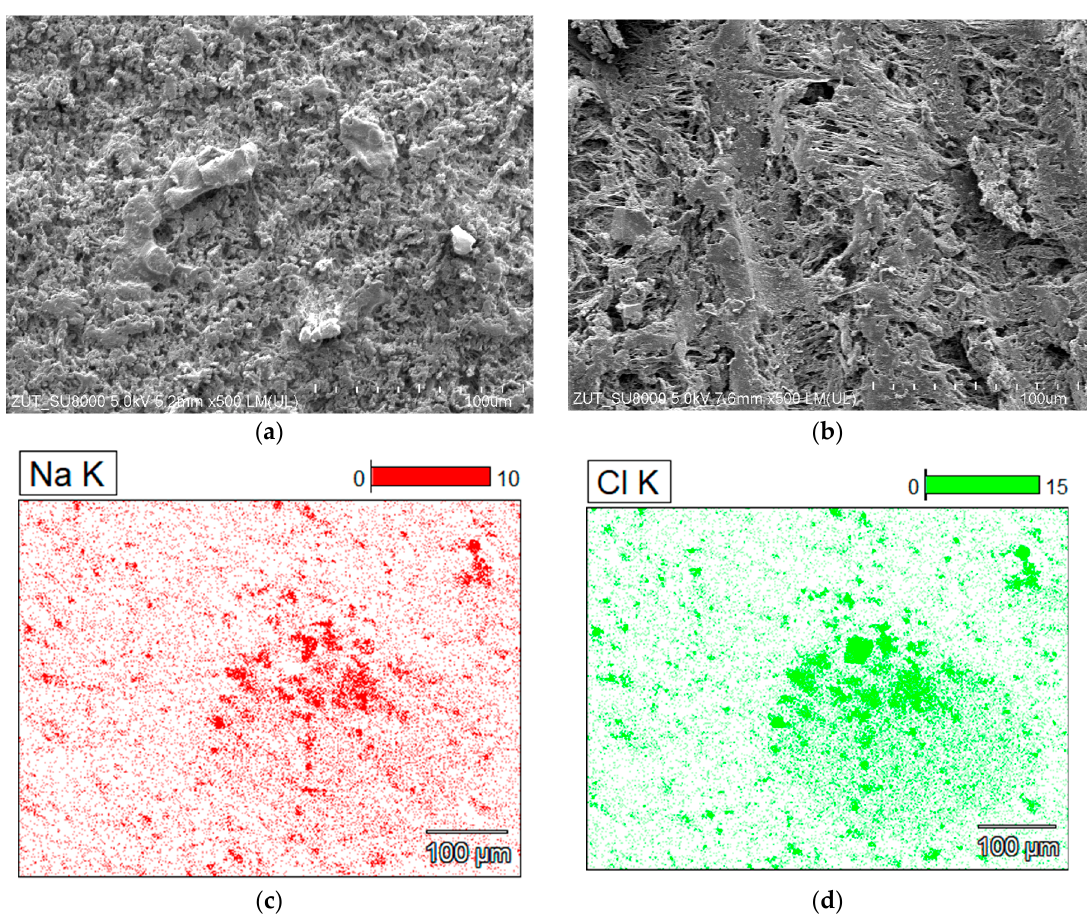
Figure 11. SEM images of the membrane surface with salt deposit collected from module: ( a ) M2—membrane V8, ( b ) M3—membrane V8N after mesh removal, and SEM-EDX analysis of V8 membrane surface (mapping): ( c ) Na and ( d ) Cl.